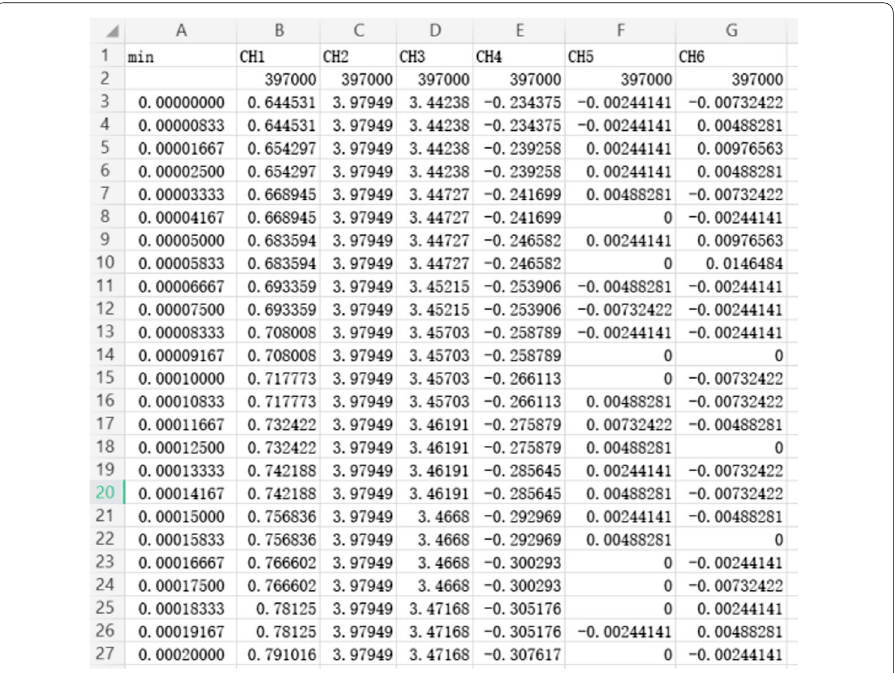
Fig. 1 Partial physiological data of experimental data